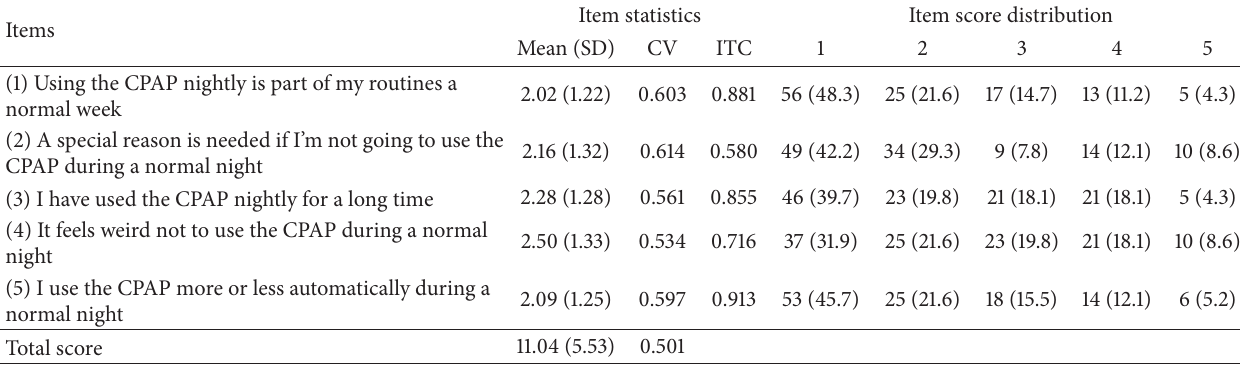
Item statistics